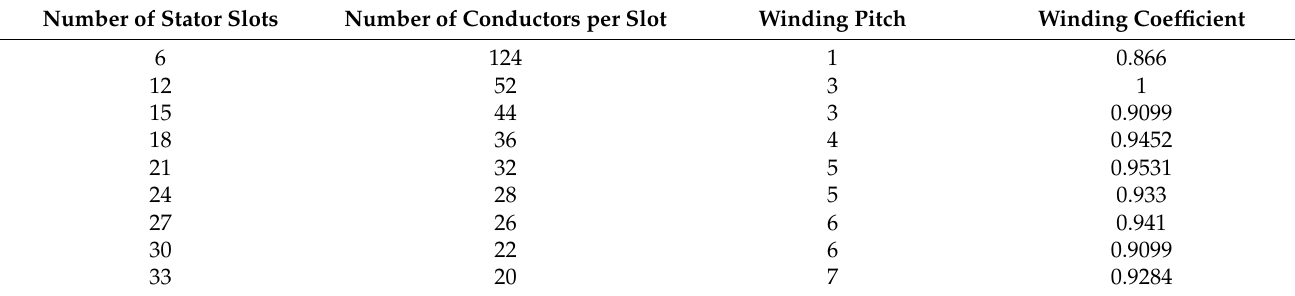
Table 2. Machine design schemes when the number of rotor poles is 4 and the number of stator slots takes different values. Number of Stator Slots Number of Conductors per Slot Winding Pitch Winding Coefficient